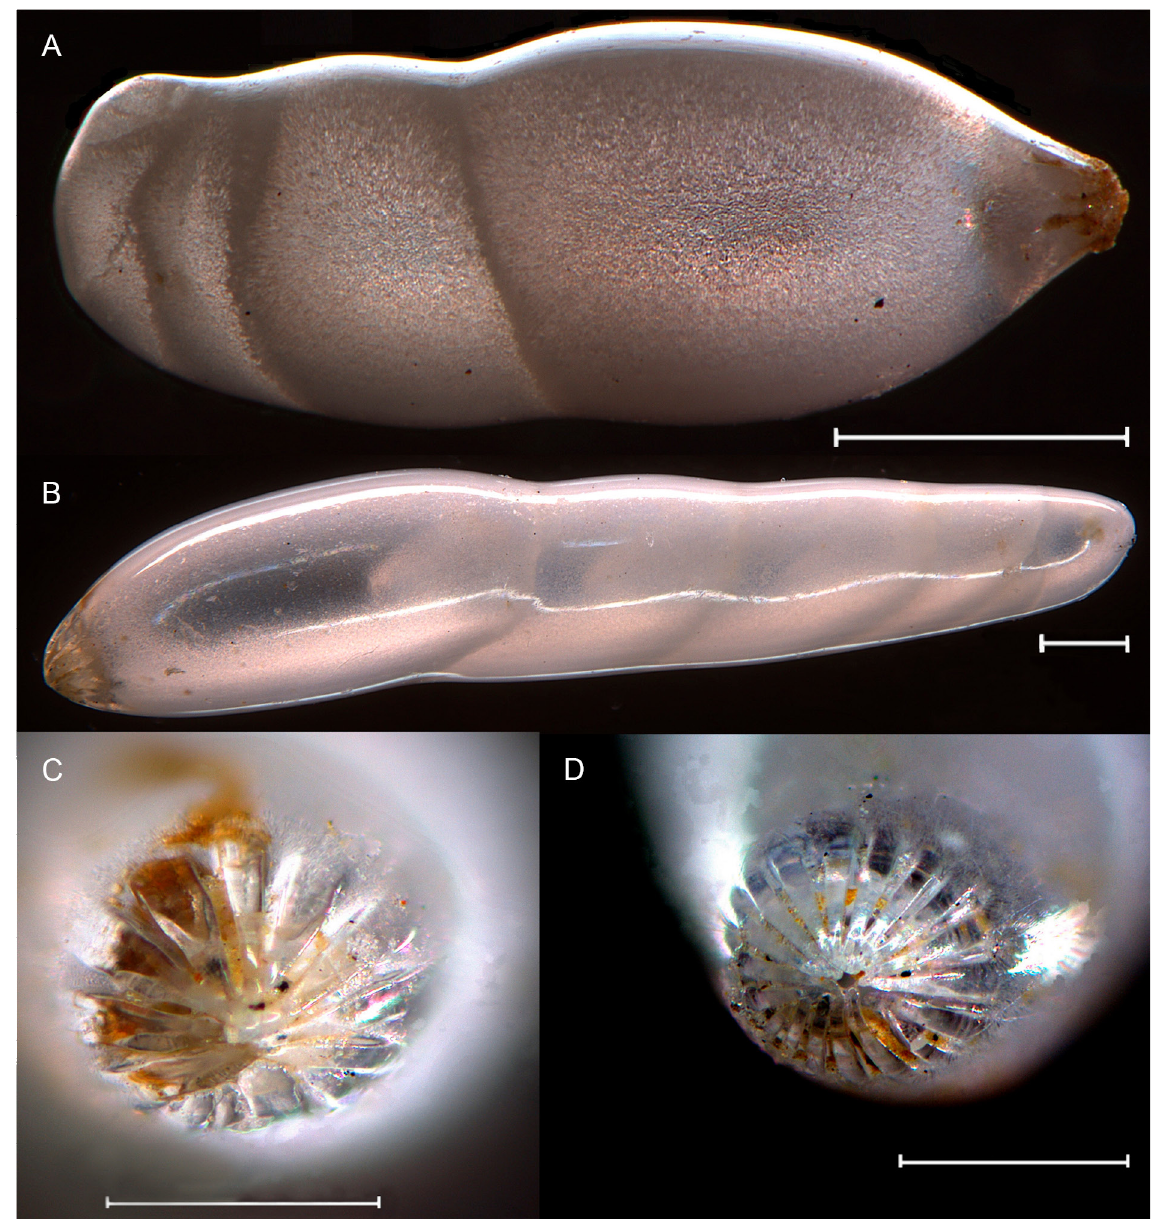
Fig. 1. Dentalina antarctica Parr, 1950. A . Side view of a young microsphere (BIOICE 2149, IINH 40405) with a spiral initial end; light source is a combination of Rotterman contrast and dark field, revealing the perforations with apparent coarse appearance. B–C . Side view (B), and apertural view (C) of megalosphere (BIOICE 2237, IINH 40408). D . Apertural view of a megalosphere (BIOICE 2697, IINH 40421). Light source in B–D is a combination of incident light and dark field. Scale bars = 0.25